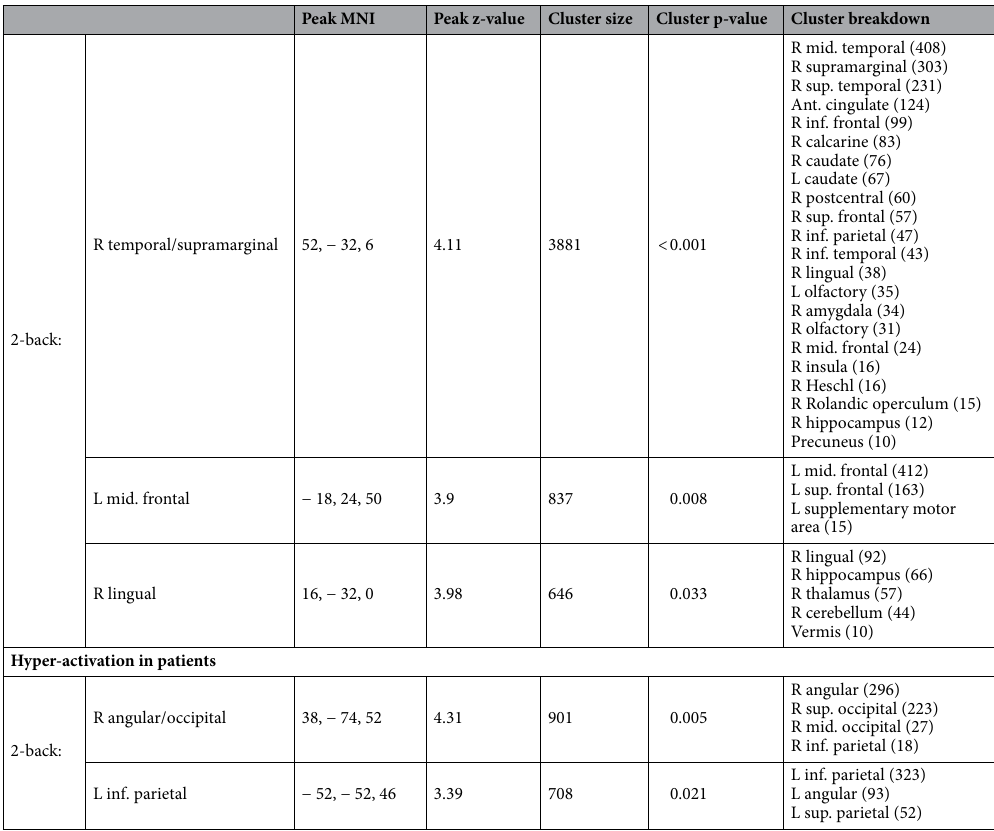
Table 3. Effects of ADHD and ADGRL3 haplotypes on the brain response during n-back task (Contrasts Patients < controls, Risk > other haplotypes, and interactions, did not returned significant results). Ant. Anterior, Inf. Inferior, L left, mid. Middle, R right, sup. superior. a In the absence of disorder-haplotype interactions. b We compared risk and protective haplotype to other